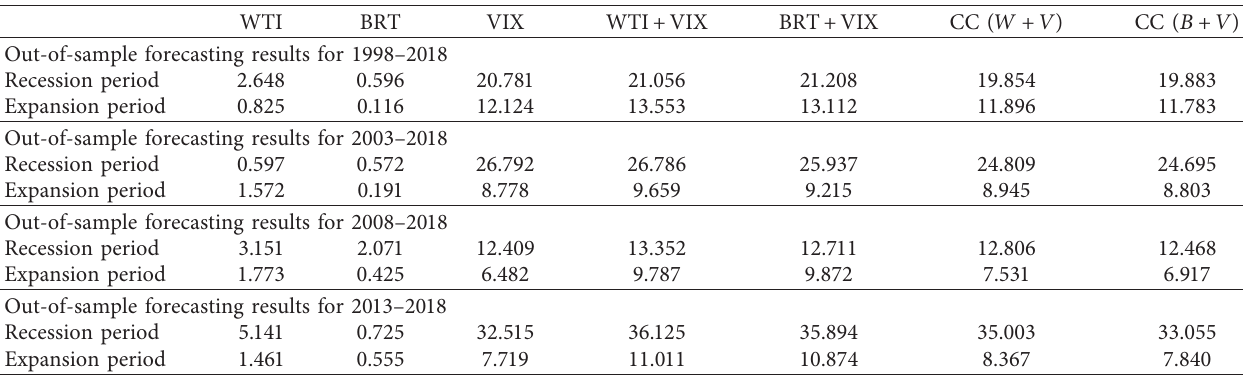
Table 5: Out-of-sample forecasting performance over business cycles.